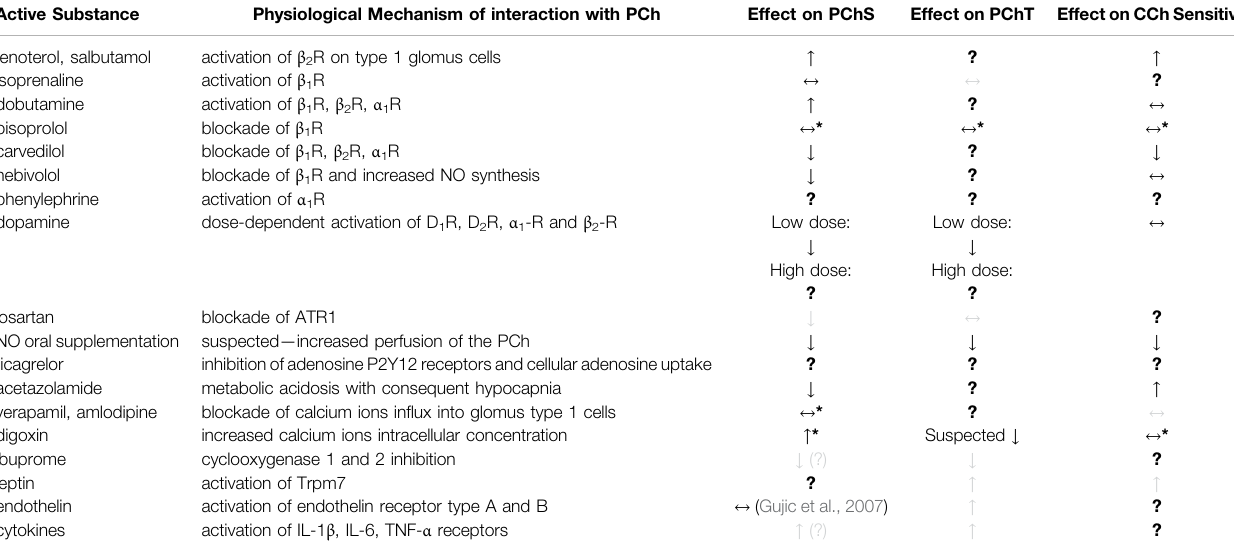
TABLE 1 | Con fi rmed and potential (based on animal data) effect of medications on chemoreceptors functionality. Active Substance Physiological Mechanism of interaction with PCh